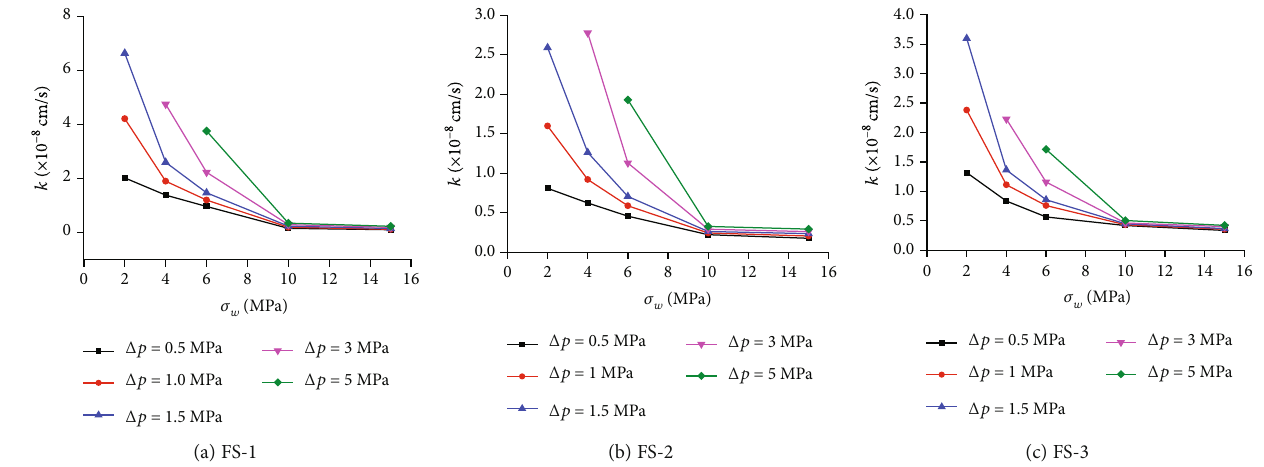
Figure 18: Relationship between permeability coe ffi cient and con fi ning pressure for FS.